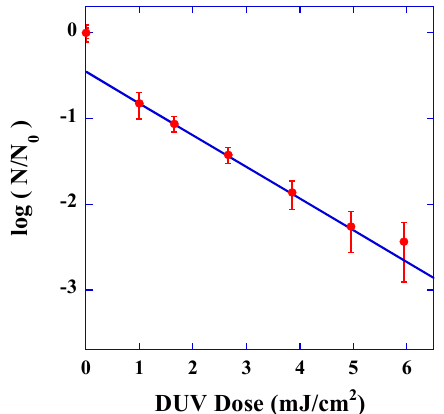
Figure 3. DUV dose–response of E. coli disinfected by water-waveguide treatment. The disinfection kinetics as a function of the DUV dose was determined by a single-target model. The DUV dose–response results could be fitted using a single disinfection constant, K EC = 0.37 (cm 2 /mJ), as shown by the solid line.